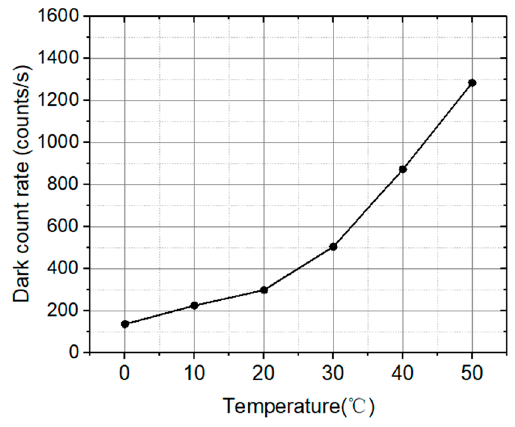
Figure 14. Dark count rate measured for various temperatures.